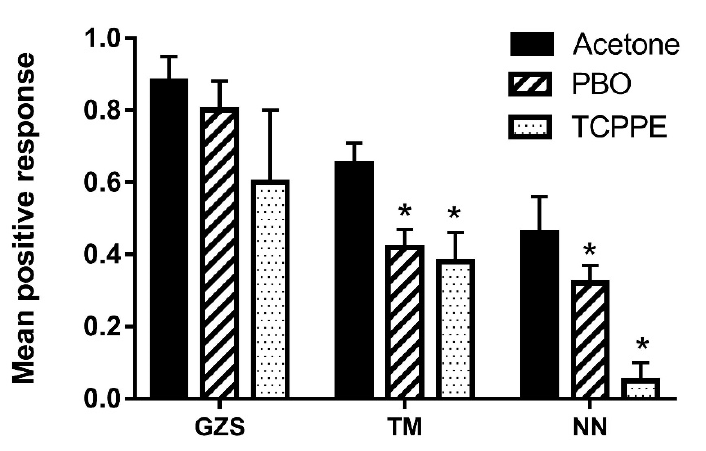
Figure 4. The effect of P450 inhibitors on the response of B. dorsalis males from the GZS susceptible strain and the two field populations to ME. Assays were performed in trap cages (30 × 30 × 30 cm 3 ) using a mixture of 100 µ L ME and 900 µ L MO, or 1 mL of MO alone (a control). No flies were trapped in the control MO cages. Data are presented as the mean ± SE. The asterisks on the histogram bars indicate significant differences compared with the control (acetone) within each B. dorsalis line according to Student’s t test ( p < 0.05).